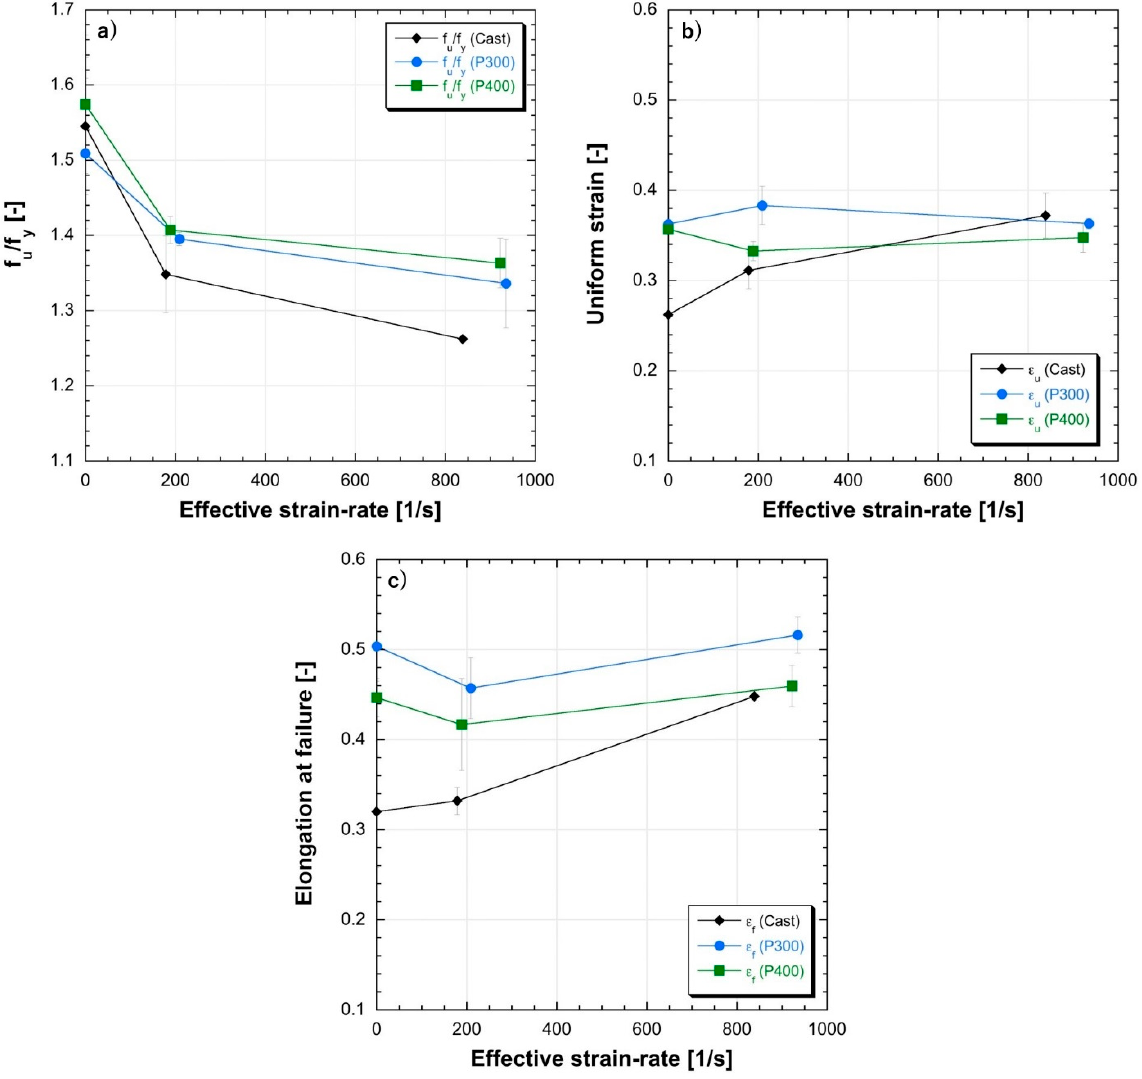
Figure 16. Ductility parameters of the realized specimens: ( a ) UTS / YS ratio; ( b ) uniform strain; ( c ) elongation at failure.